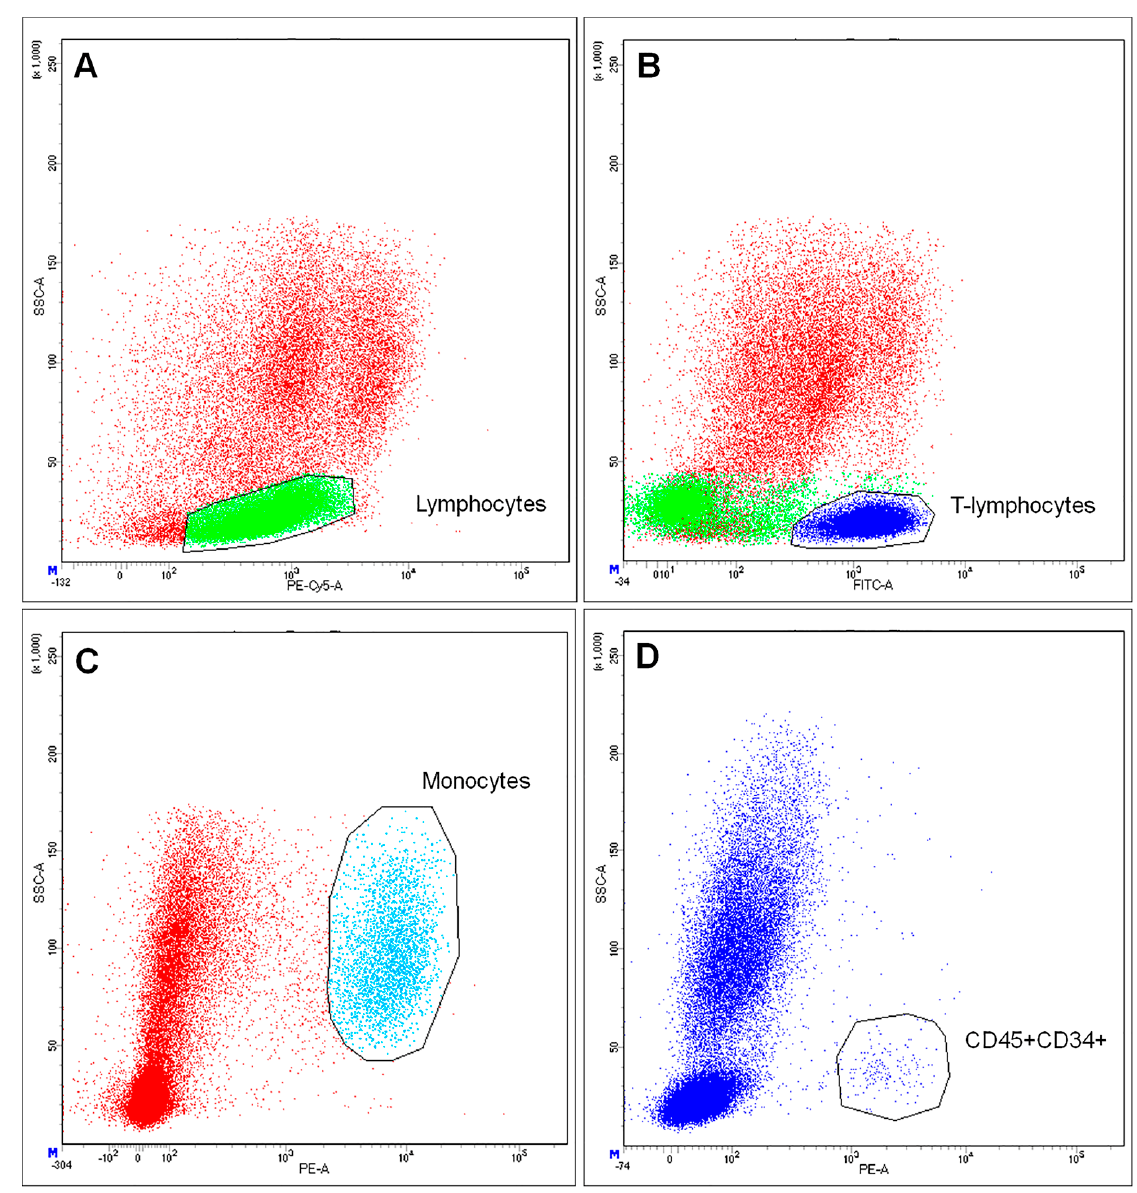
Figure 1. Determination of immune phenotype of umbilical cord blood mononuclear cells. ( A ) staining for CD45, selected green area–Lymphocytes; ( B ) staining for CD3, selected dark blue area–T-lymphocytes; ( C ) staining for CD14, selected blue area–Monocytes; ( D ) staining for CD34, selected events–CD45+ CD34+ cells.